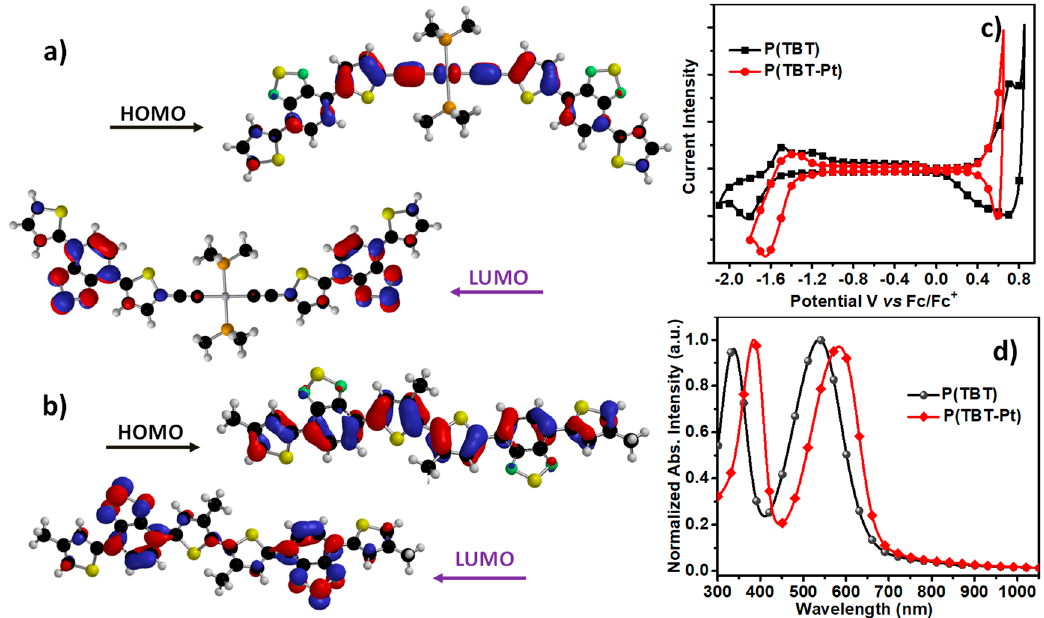
Figure 1. Highest occupied molecular orbital (HOMO) and lowest unoccupied molecular orbital (LUMO) distribution of ( a ) the P(TBT-Pt) and ( b ) the P(TBT) dimers (with alkyl side chain being simplified to methyl). The ( c ) cyclic voltammetry (CV) curves and ( d ) UV-Vis-NIR absorption spectra of these two polymers.